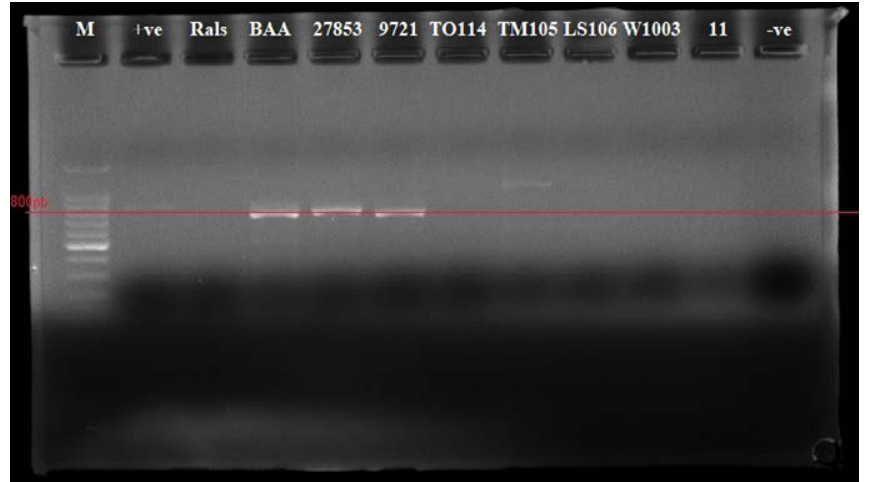
Fig. 3 . Identifying the Nir gene by PCR amplification from our isolates collection. The PCR expected size is 800 bp and was obtained. 1.100bp Marker, 2. +ve control, 3.Rals, 4.BAA, 5. 27853, 6. 9721, 7. TO114, 8. TM105, 9. LS106, 10. W1003, 11. –ve